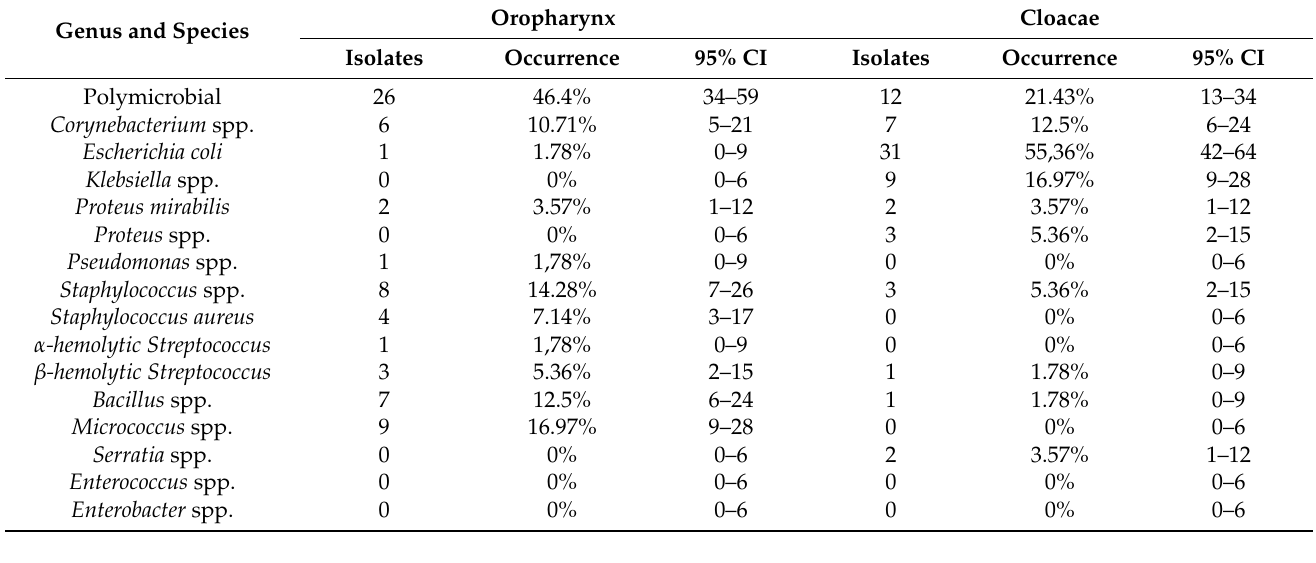
Table 1. Isolates, occurrence and its 95% confidence interval, of aerobic bacteria isolated from the oropharynx and cloaca in 56 wild Andean condors (R í o Negro province, Argentina).